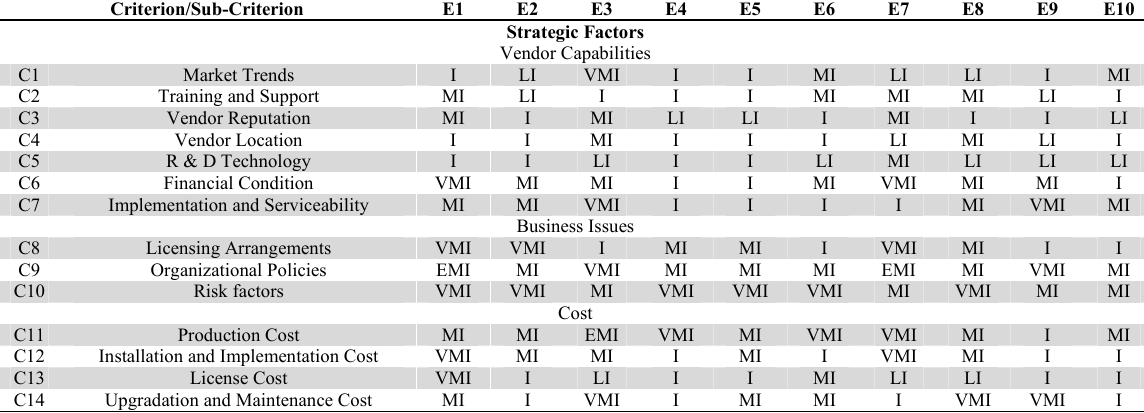
Criteria weights assigned by the Experts in linguistic terms on a 7-point fuzzy scale Criterion/Sub-Criterion